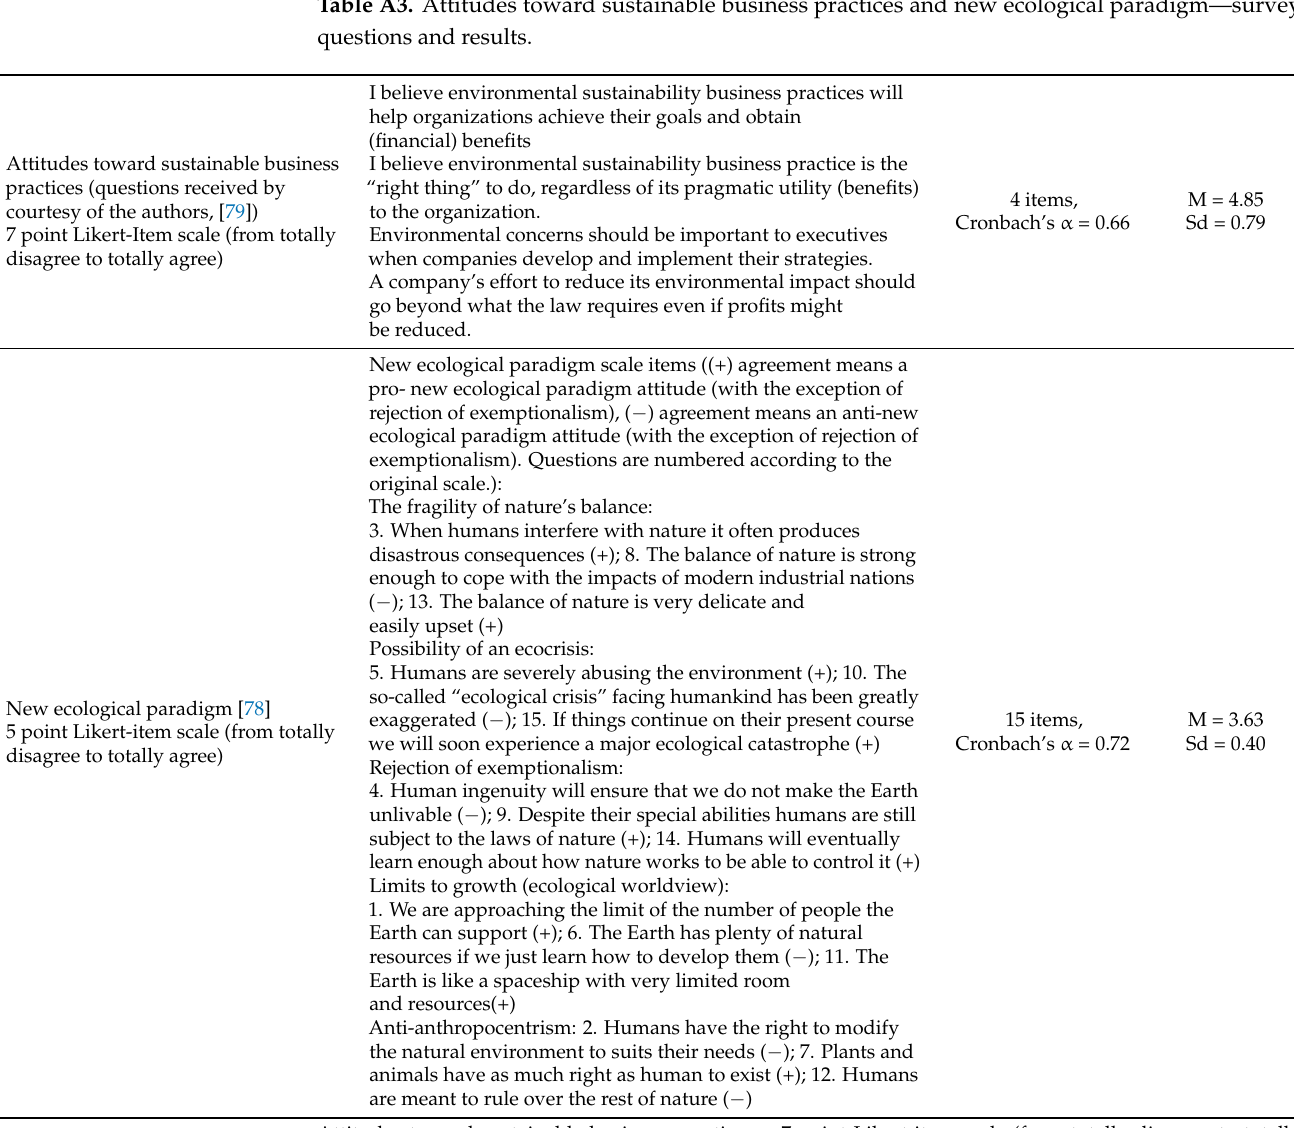
Table A3. Attitudes toward sustainable business practices and new ecological paradigm—survey questions and results.